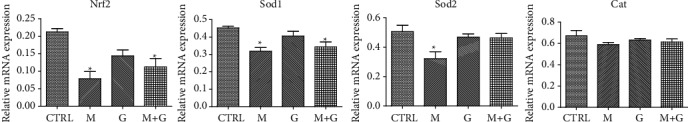
Gene expression of Nrf2 and downstream antioxidative genes. ∗Significantly different from CTRL at P < 0.05; #significantly different from group M at P < 0.05.